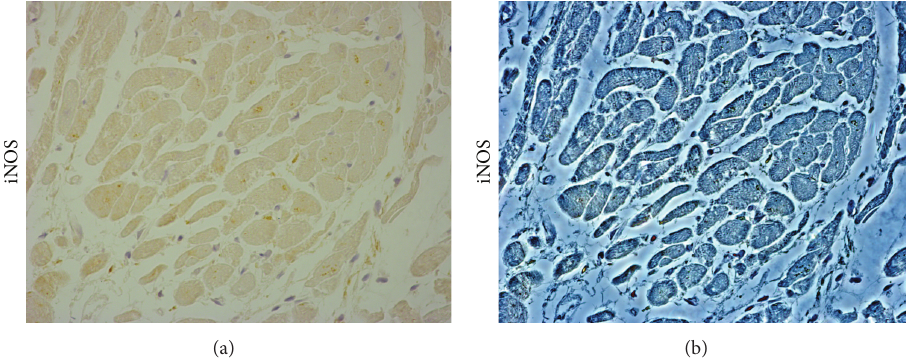
Figure 2: Inducible nitric oxide synthase (iNOS) expression in the cardiac tissue of patient died following sepsis. Bright field (a) and contrast